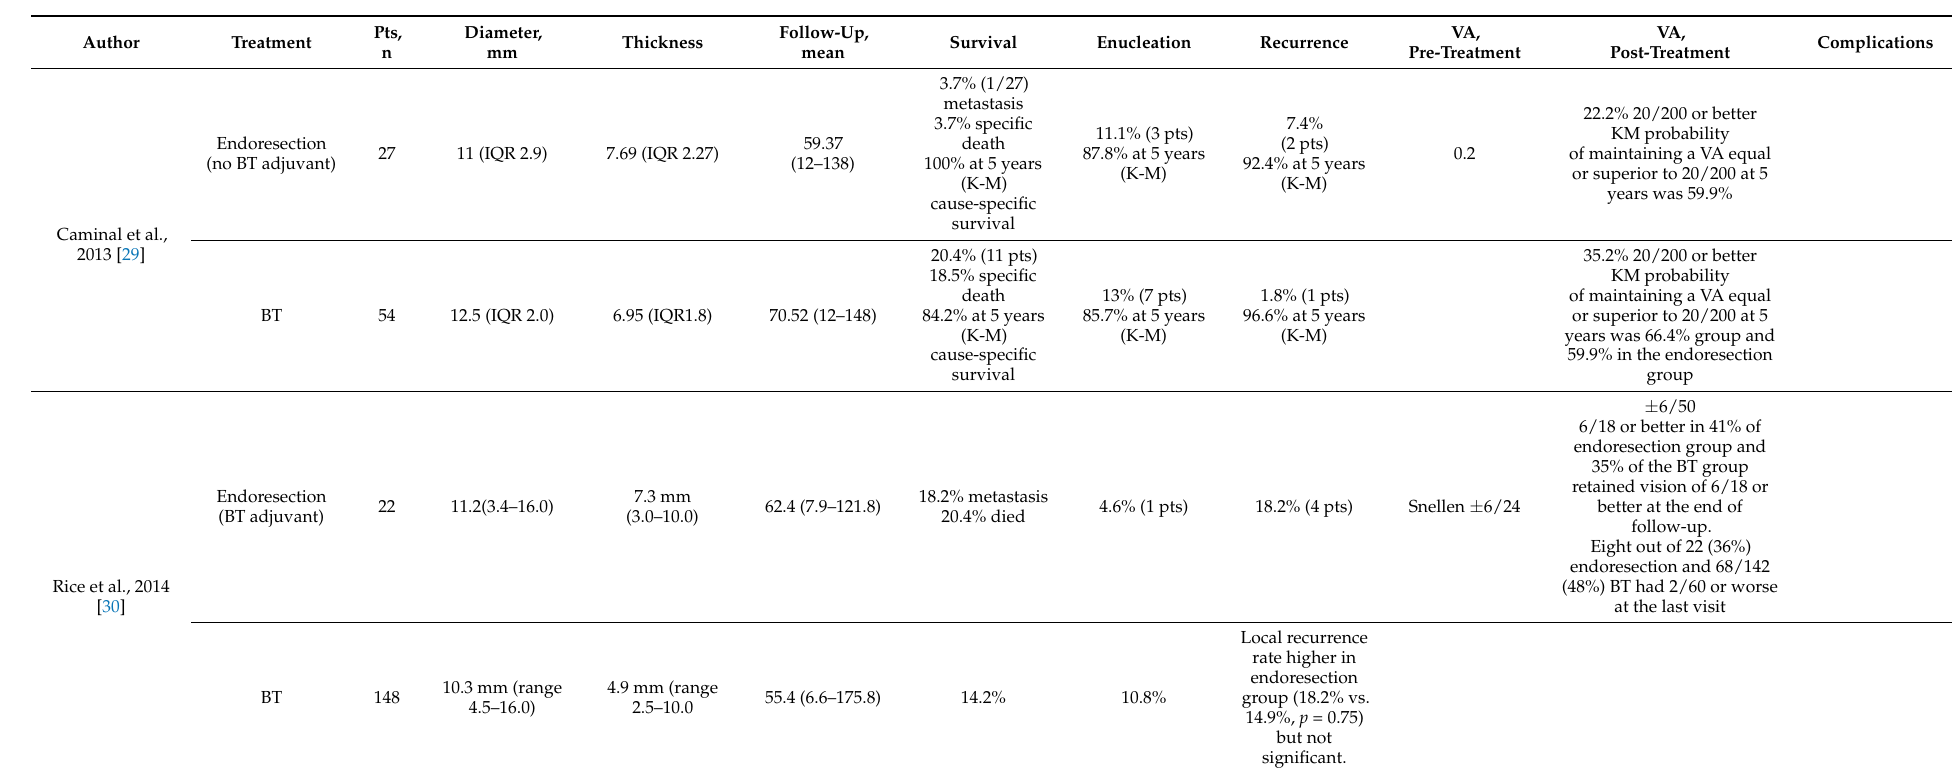
Table 5. Summary of case-control studies of endoresection for uveal